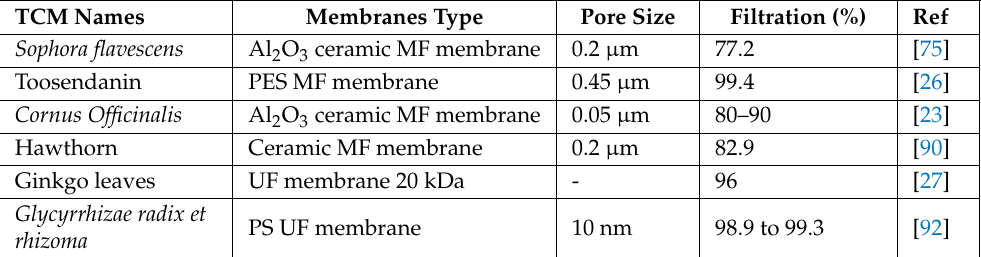
Table 3. Some examples of membrane technology of TCM extracts